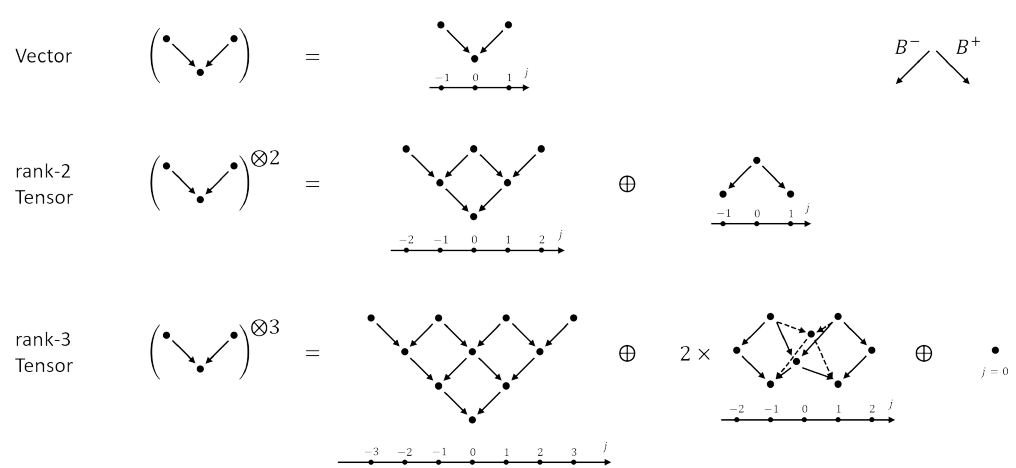
Figure 20: The first three lowest-rank tensor representations. The axes beneath every irreducible representations show the spins, and the arrows label the connection by B